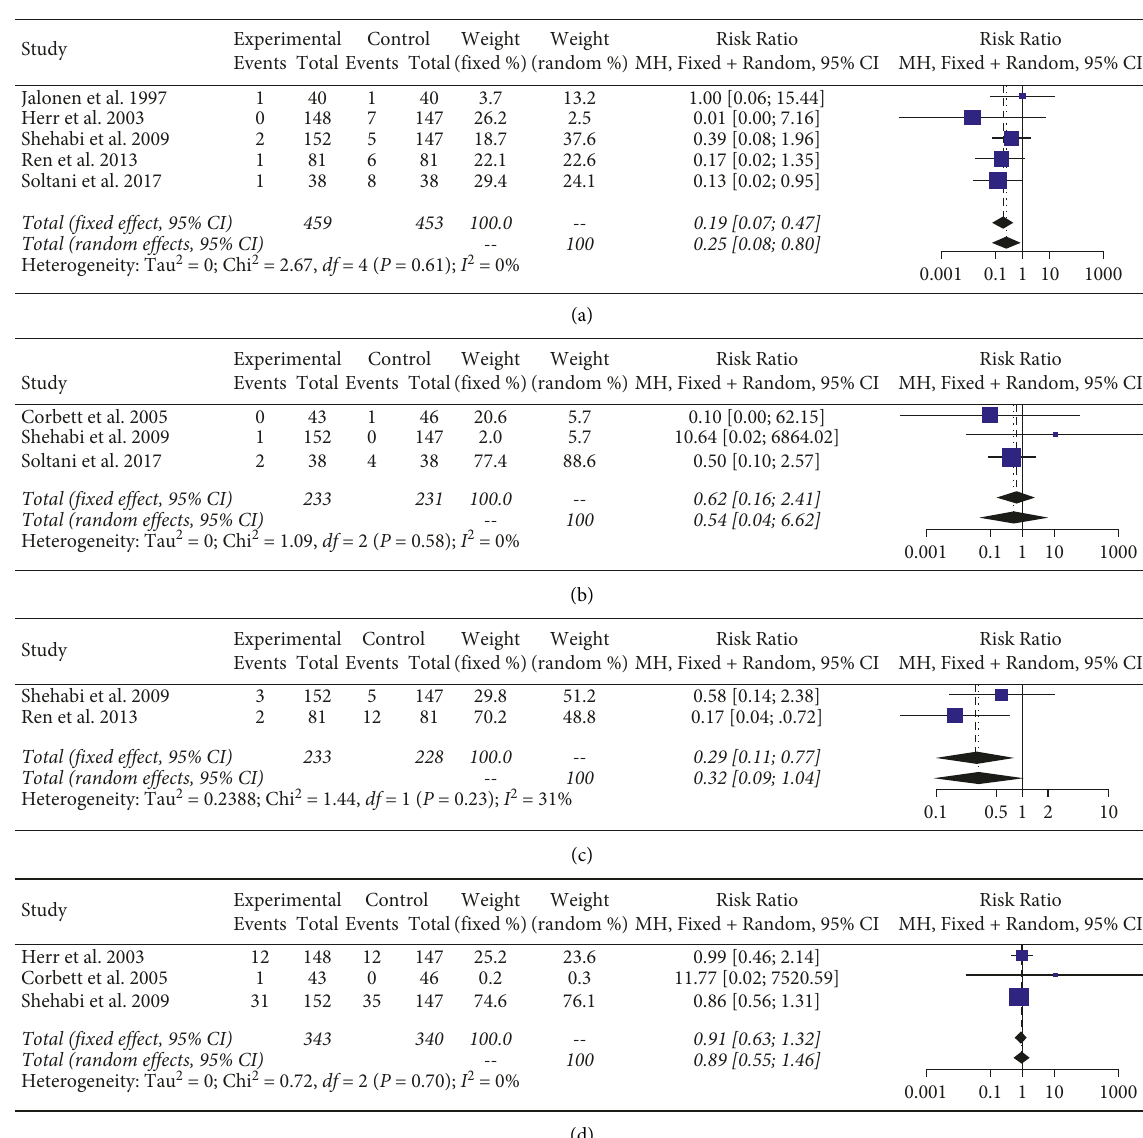
Figure 3: Meta-analysis of (a) ventricular tachycardia, (b) ventricular fibrillation, (c) supraventricular tachycardia, and (d) atrial